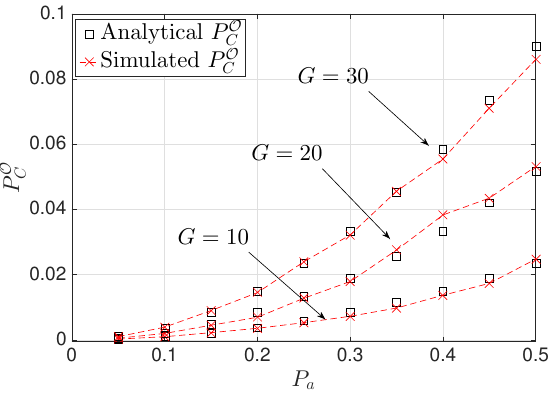
Figure 2. P O versus P a , for different values of R TX / C